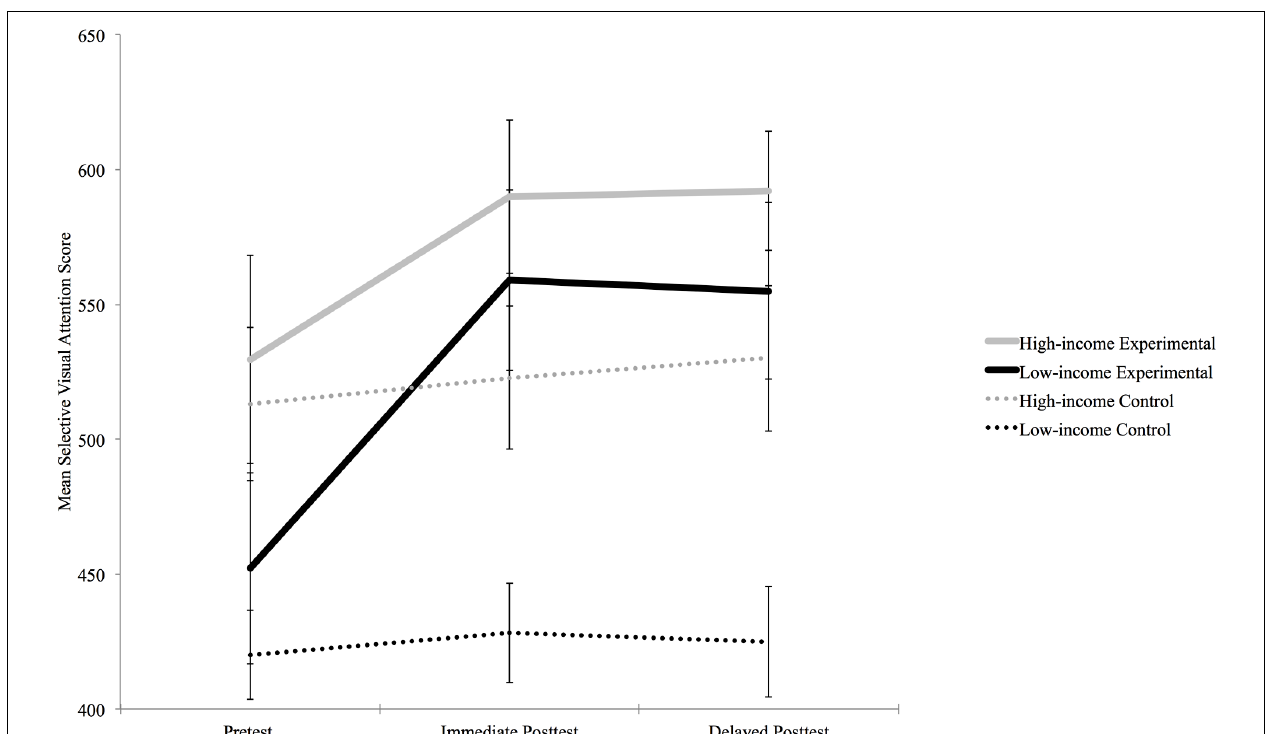
FIGURE 1 | Selective visual attention pretest, immediate posttest, and delayed posttest scores for high- and low-income participants in the experimental and control